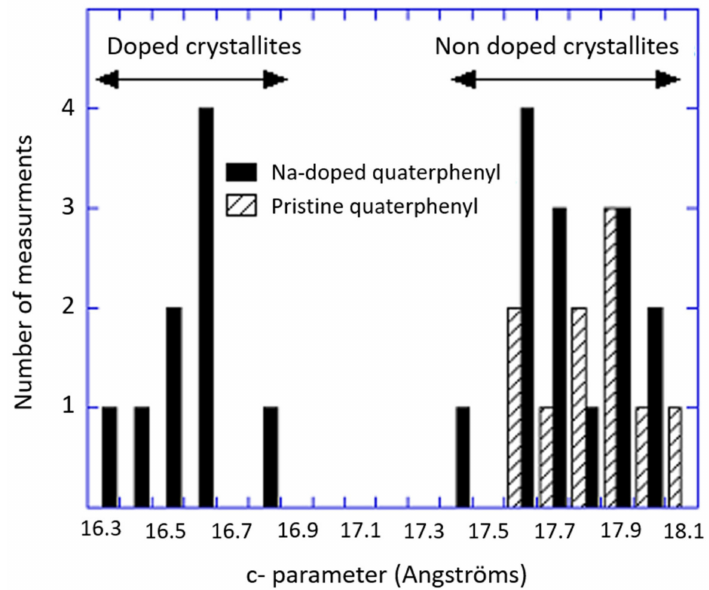
Figure 1. The comparative histograms of the pristine and Na-doped